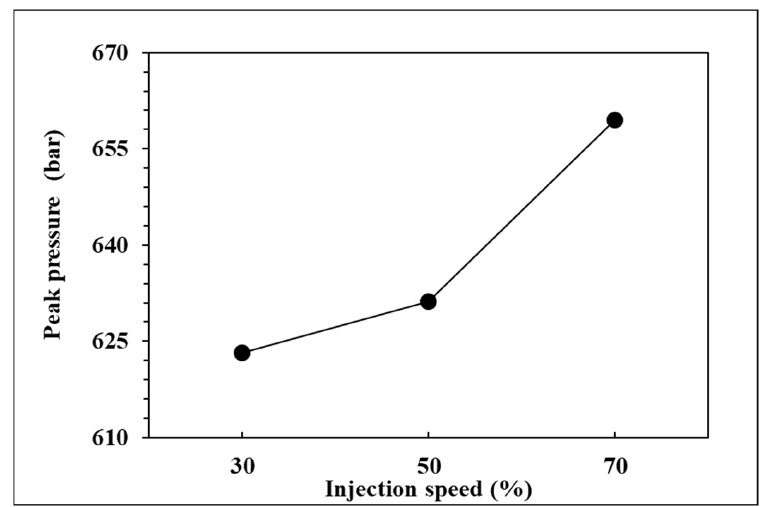
Figure 13. Relationship between viscosity index and injection speed .